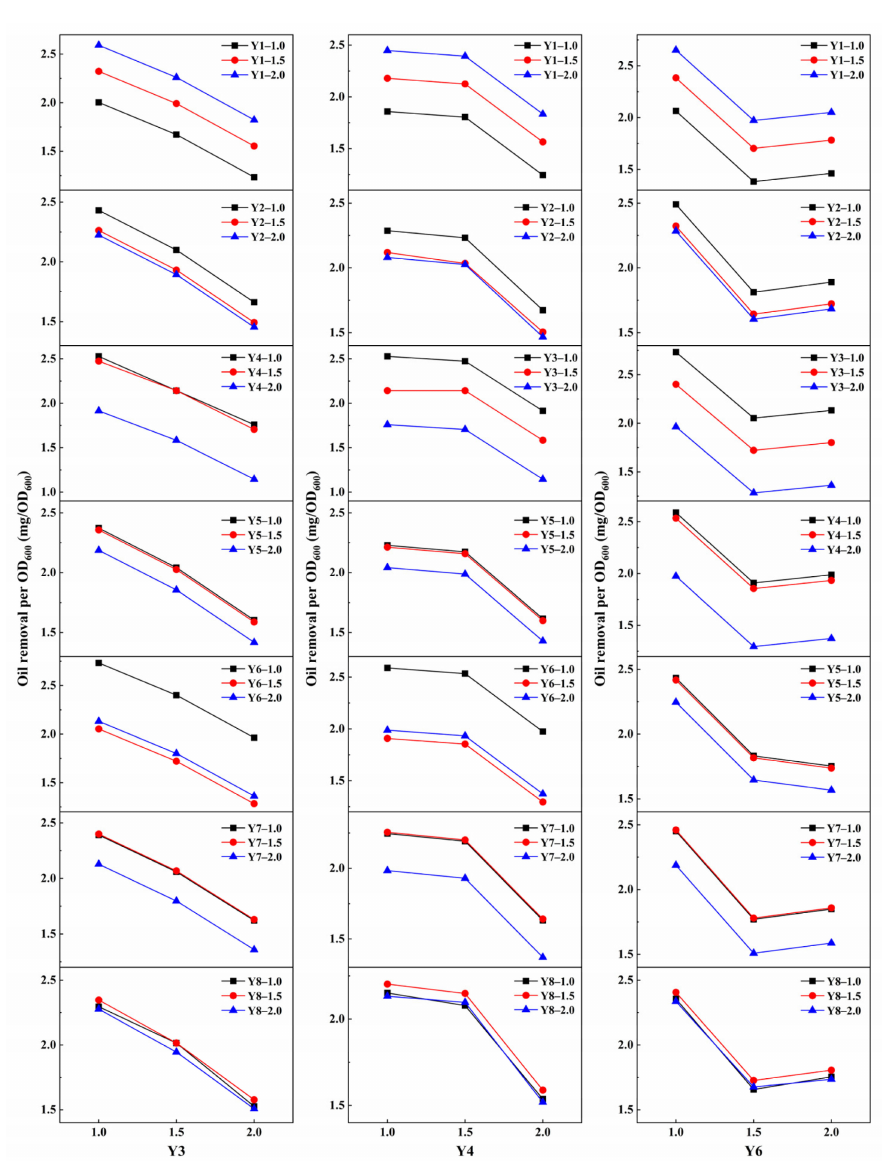
Figure 5. Analysis of the interspecific relationships between isolates (Y3, Y4, and Y6) at differ- ent